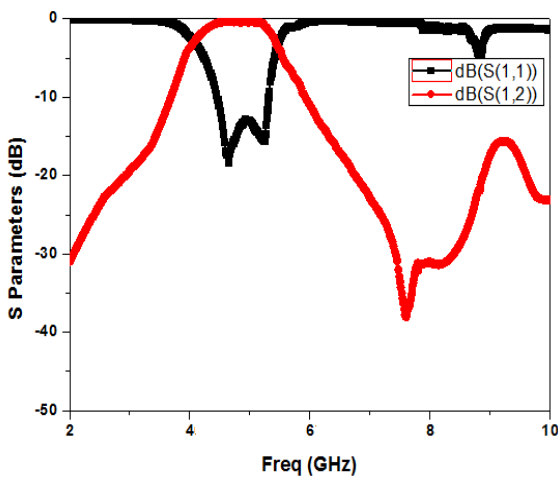
Figure 9. Frequency response of HMSIW BPF with CSRR unit cell. 5. Design of Proposed Fractal HMSIW BPF Integrated with CSRR and Fractal DGS Etched on the Bottom